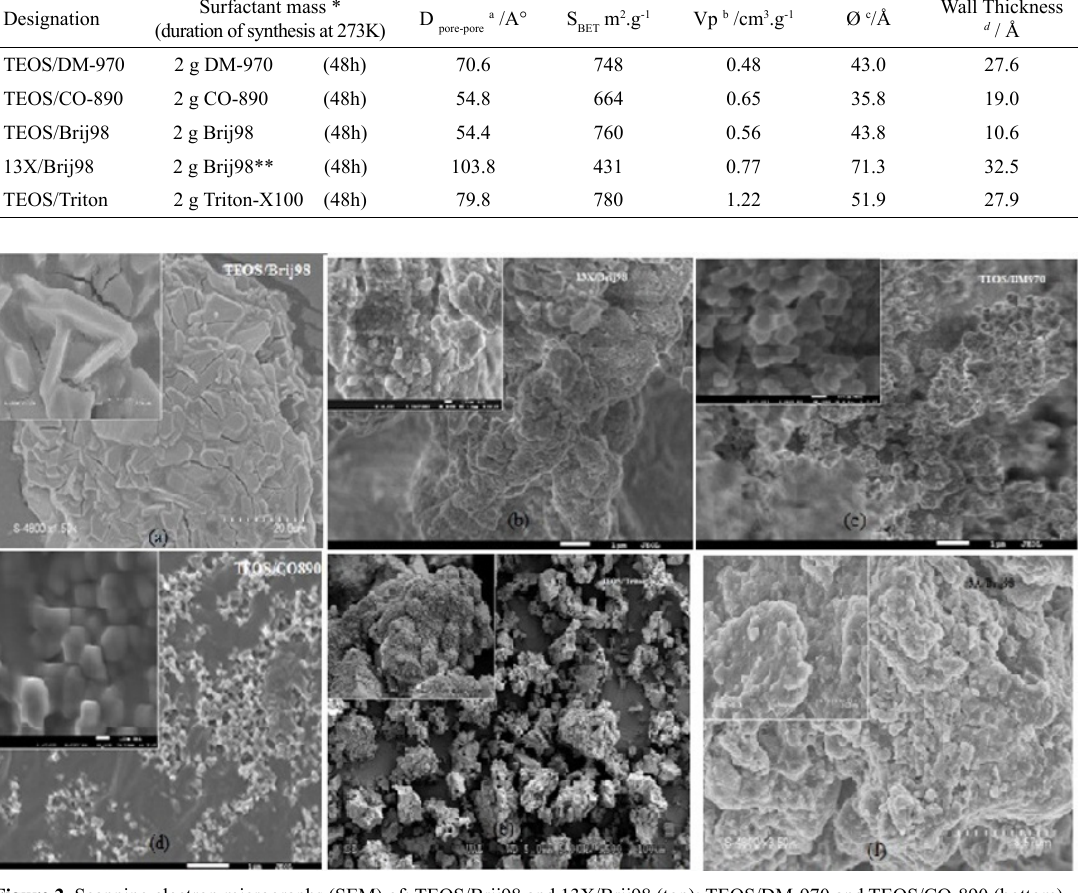
Table 2: Textural and structural parameters of materials calcined at 550°C under air for 6 hours. * used with 30g H TEOS. **used with 1g of Na-X zeolite. a d value of characteristic reflection of the calcined products. b Calculated at P/P°=0.99; c Pore diameter calculated from desorption branch with BJH method. d Calculated from t = D